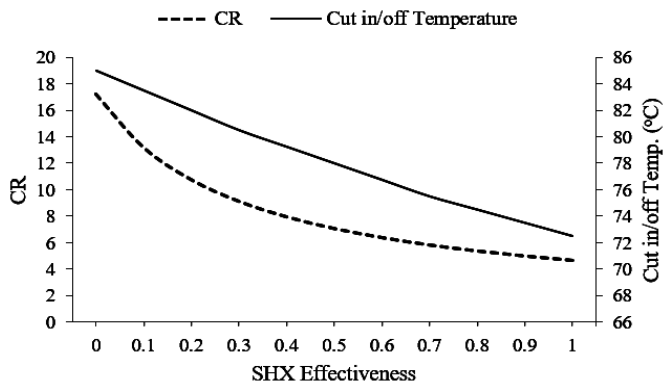
Figure 33. Effect of ε SHX on the CR and cut in/off temperature.